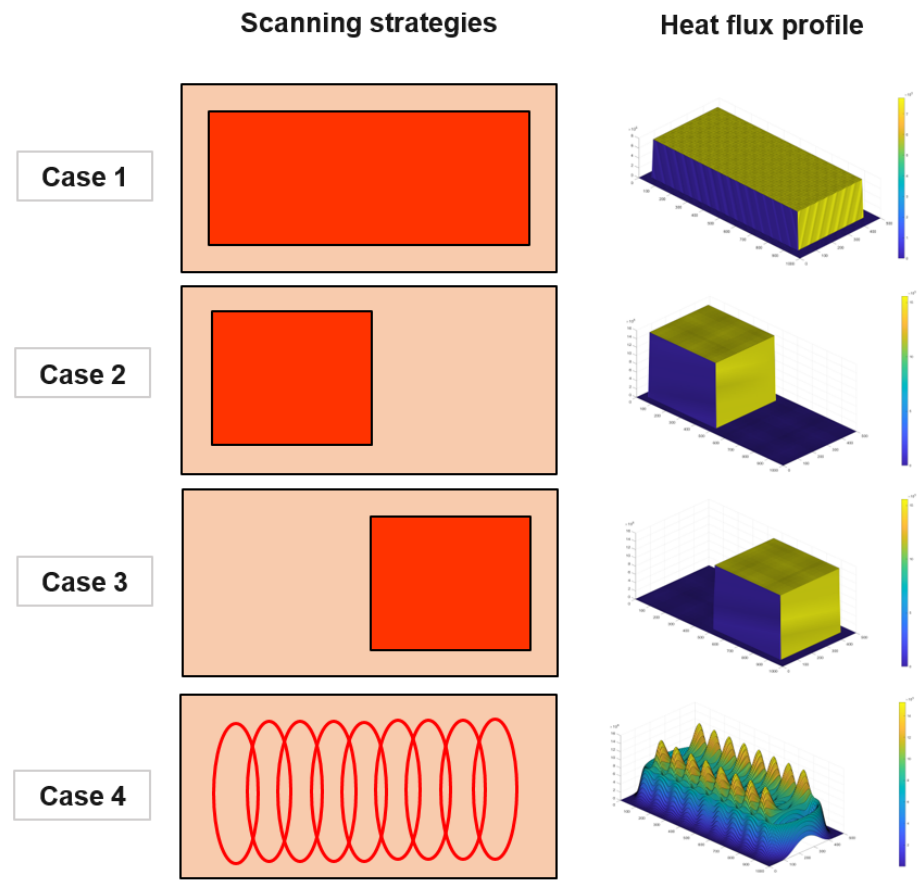
Figure 3. The four scanning strategies.